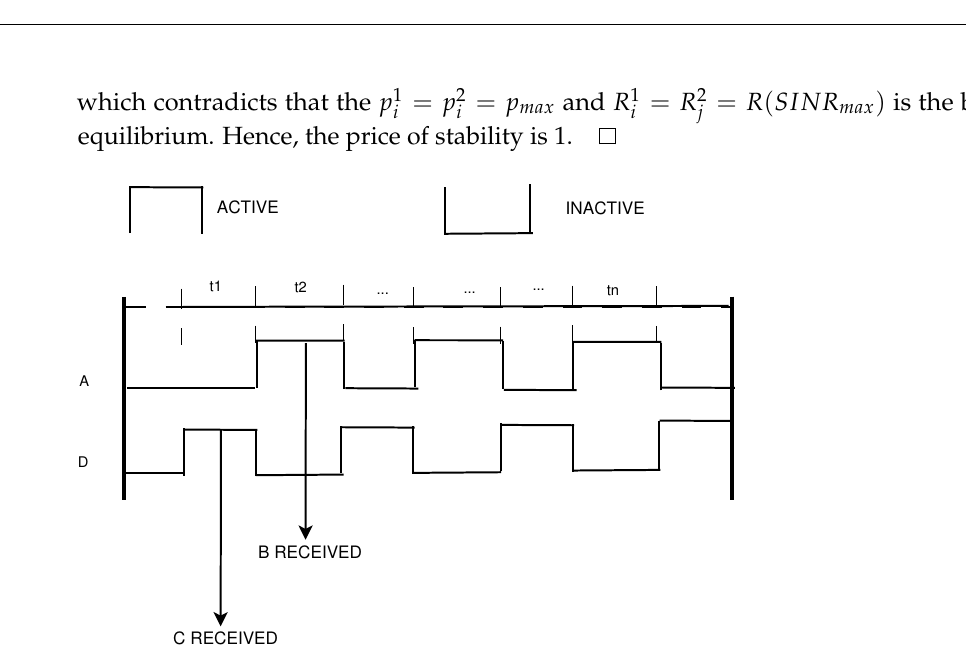
Figure 4. Messages Received with Duty Cyclin ©2022 IEEE. Reprinted, with permission, from Spyrou, E. D., & Mitrakos, D. (2021, June). On the Potential Game of Packet Reception Ratio Utility Functions in Wireless Sensor Networks. In 2021 29th Mediterranean Conference on Control and Automation (MED) (pp. 880–885).